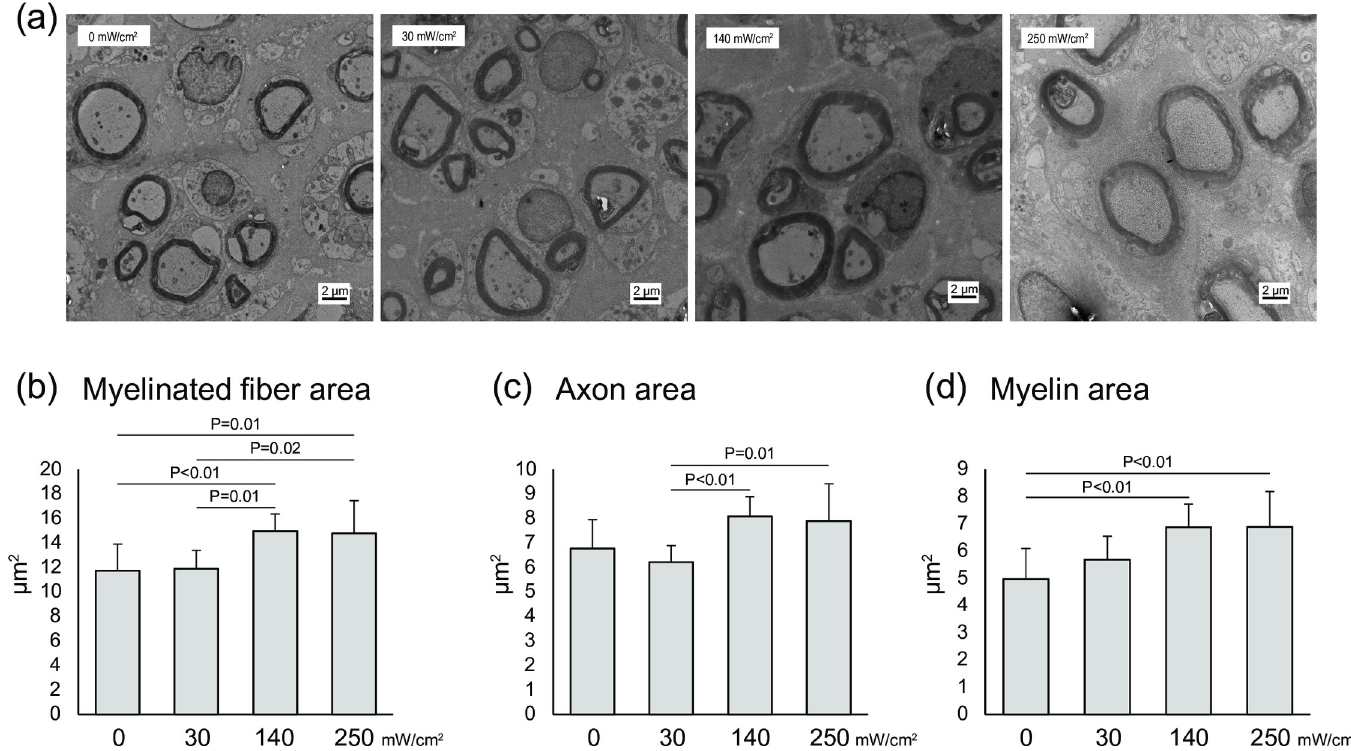
Fig 3. Transmission electron micrographs of the sciatic nerve. (a) Representative images of the transmission electron micrograph of the sciatic nerve. (b) Mean myelinated fiber area, (c) mean axon area, (d) mean myelin area. All data are presented as mean ± SD (n = 9).